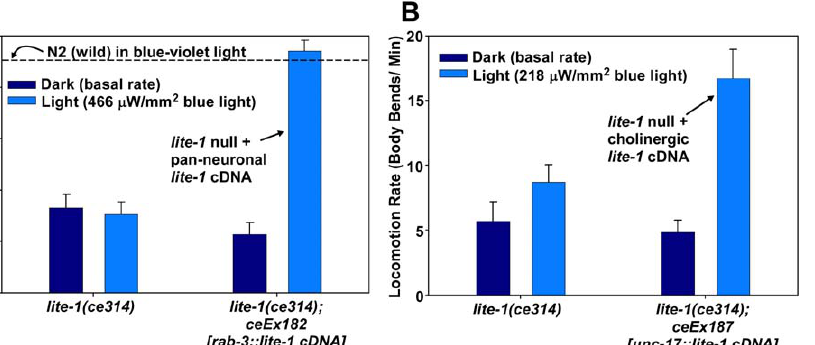
Figure 8. Expressing LITE-1 Pan-Neuronally Fully Rescues the Light Response, Whereas Expression Only in Cholinergic Motor Neurons Confers Partial Rescue (A) Expressing LITE-1 pan-neuronally is sufficient to rescue the light response of a lite-1 null. Shown are the mean locomotion rates of each strain in low power white light (dark bars) or a low power of blue light (see Materials and Methods). Higher powers paralyze lite-1 transgenic animals (Video S8). Error bars are the standard errors in populations of ten animals. (B) Expressing LITE-1 in cholinergic motor neurons partially rescues the light response of a lite-1 null. Legend description for (A) applies. See also Video S9, which shows that these animals coil up and become paralyzed under higher light powers.